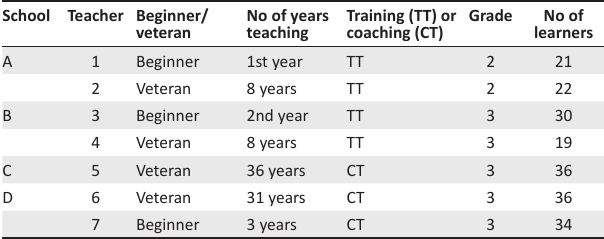
TABLE 1: Biographical details of teachers observed in four schools. School Teacher Beginner/